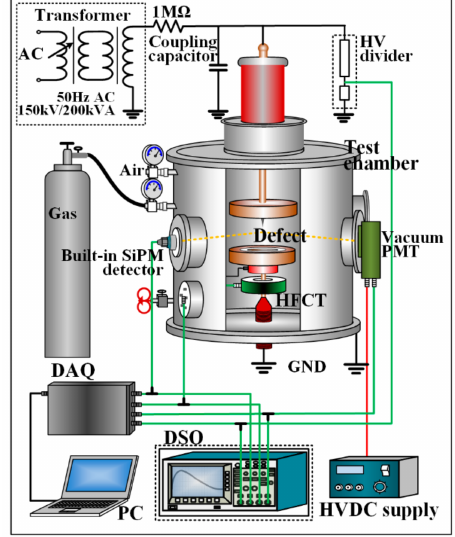
Figure 4. Synchronous PD measurement